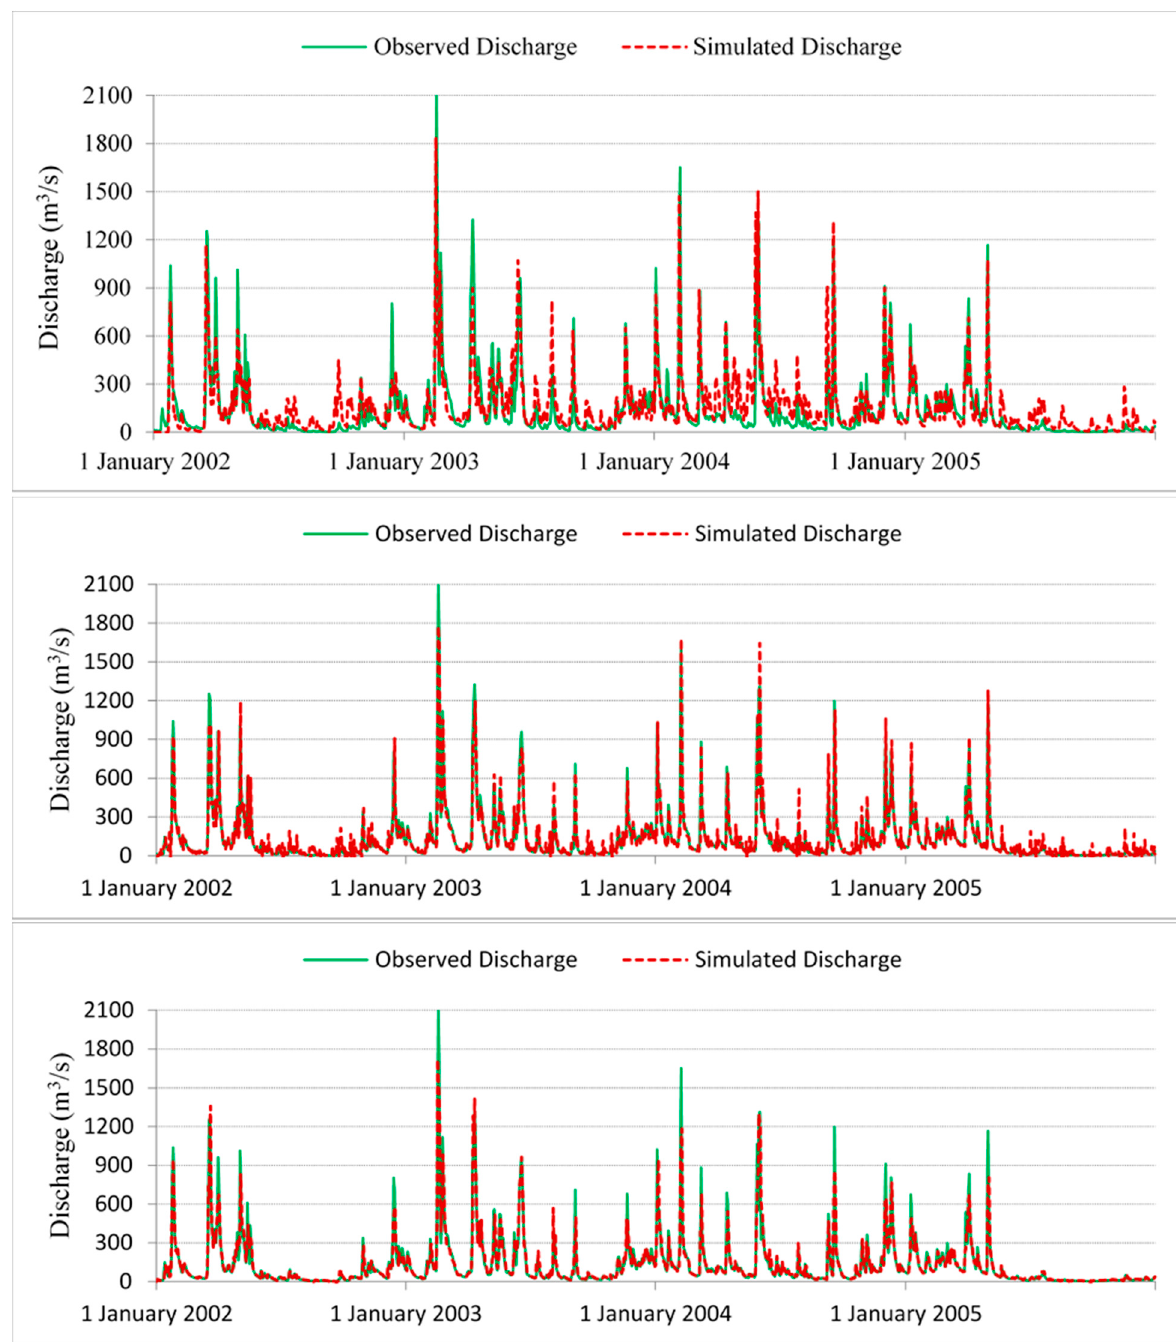
Figure 8. Daily discharge calibration for SWAT ( top ), ARX ( middle ), and GEP ( bottom ) at LD14 for time-period 2002–2005.